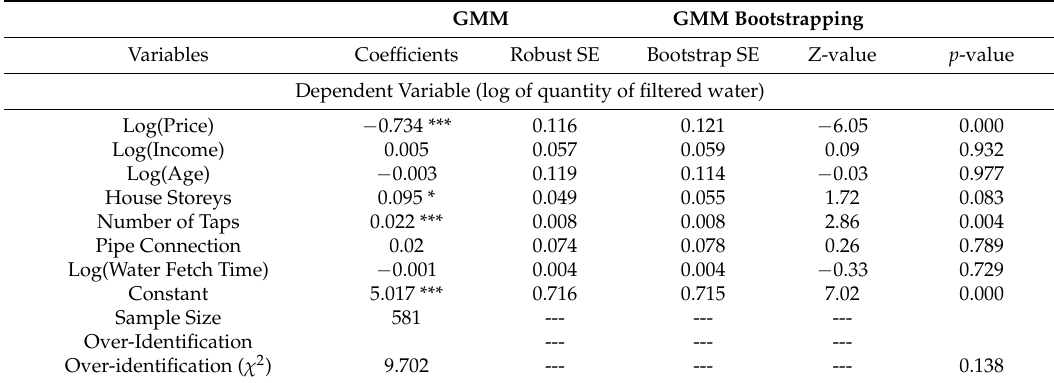
Table A5. Generalized method of moment estimation of residential water demand (unfiltered).